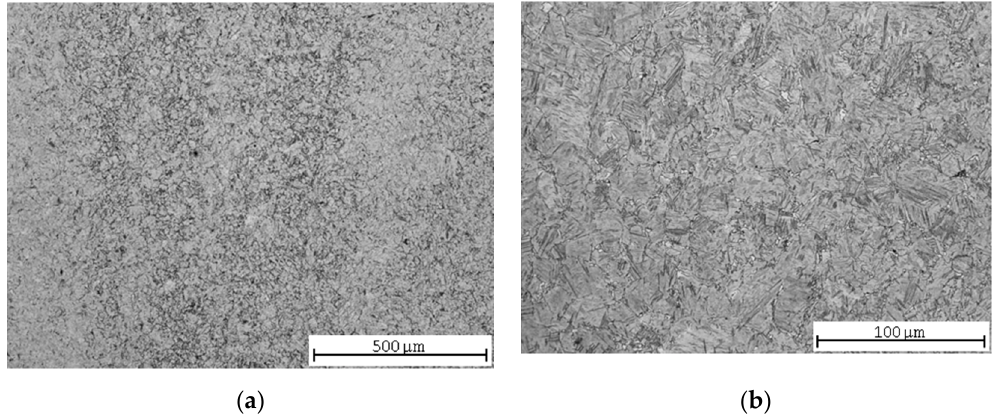
Figure 7. 37MnSi5 steel microstructures after quenching: ( a ) central part; ( b ) detail.